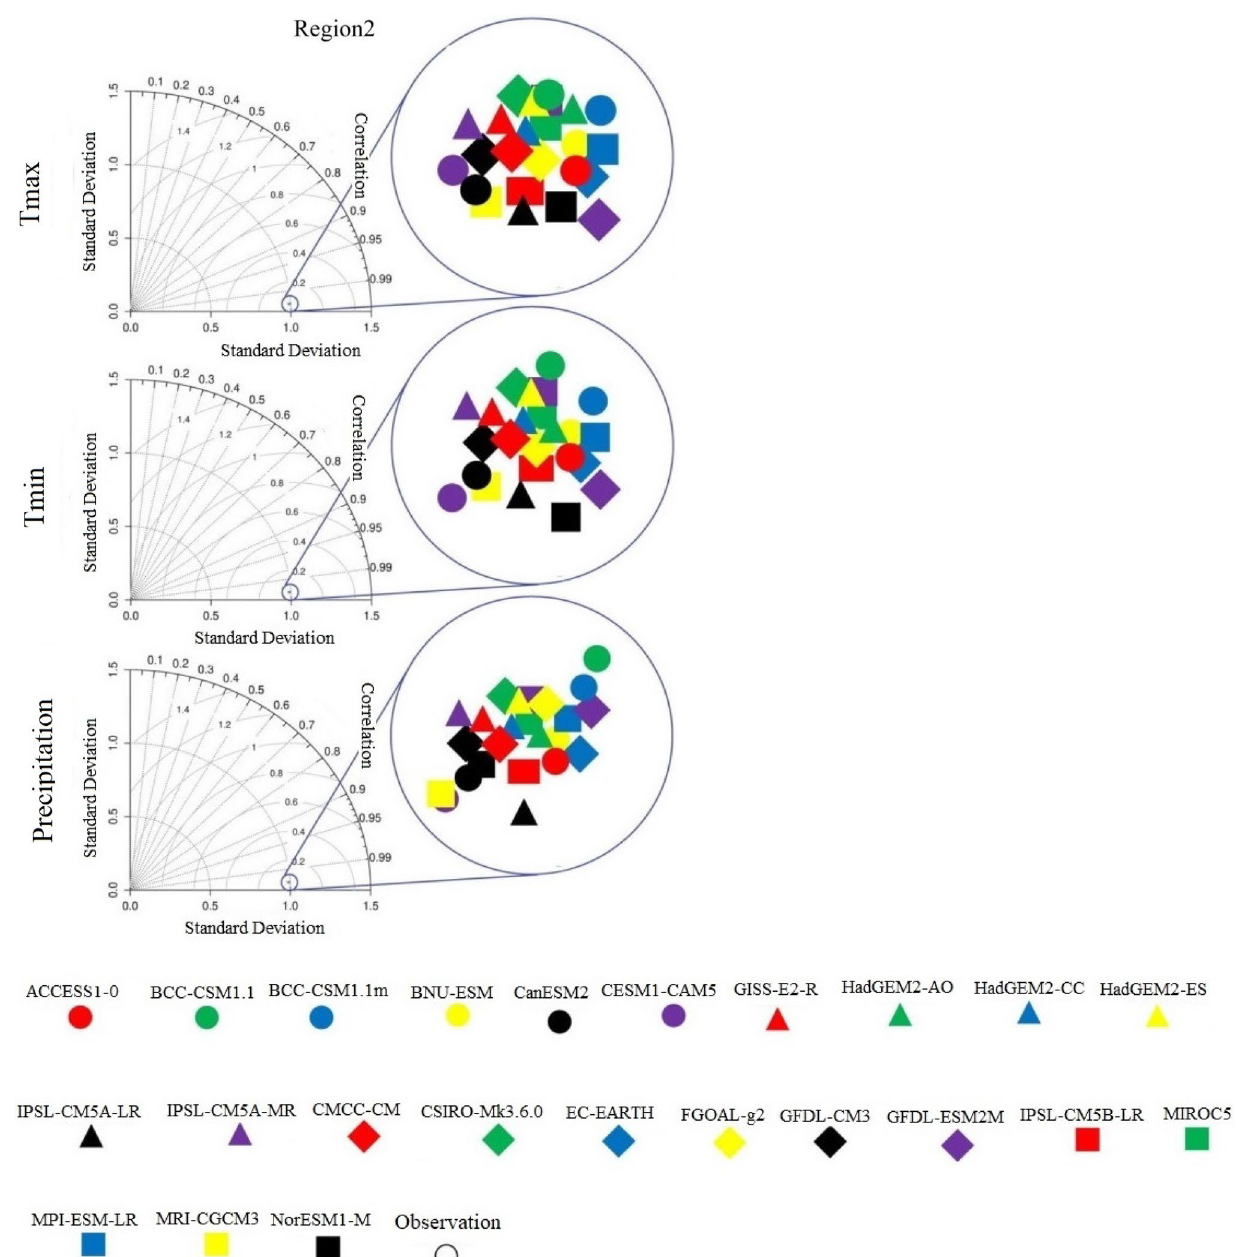
Fig. 14 Taylor diagrams for PCP, Tmax, and Tmin in region 2 in the baseline period